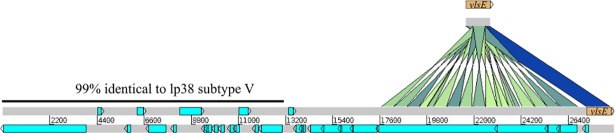
The Vls antigenic variation system in B. burgdorferi MM1.This locus on lp28-8 plasmid contains the expression site vlsE as well as a contiguous array of 18 DNA sequence blocks that are each at least 85% identical to vlsE (BbuMM1_RS290). BLAST alignments between the MM1 vlsE locus and lp28-8 plasmid are indicated by blocks ranging in color from green (85% sequence identity) to dark blue (100% sequence identity) with a minimum Score Cutoff of 85. The leftmost 13134 bps of lp28-8 plasmid is 99% identical to lp38 subtype V.